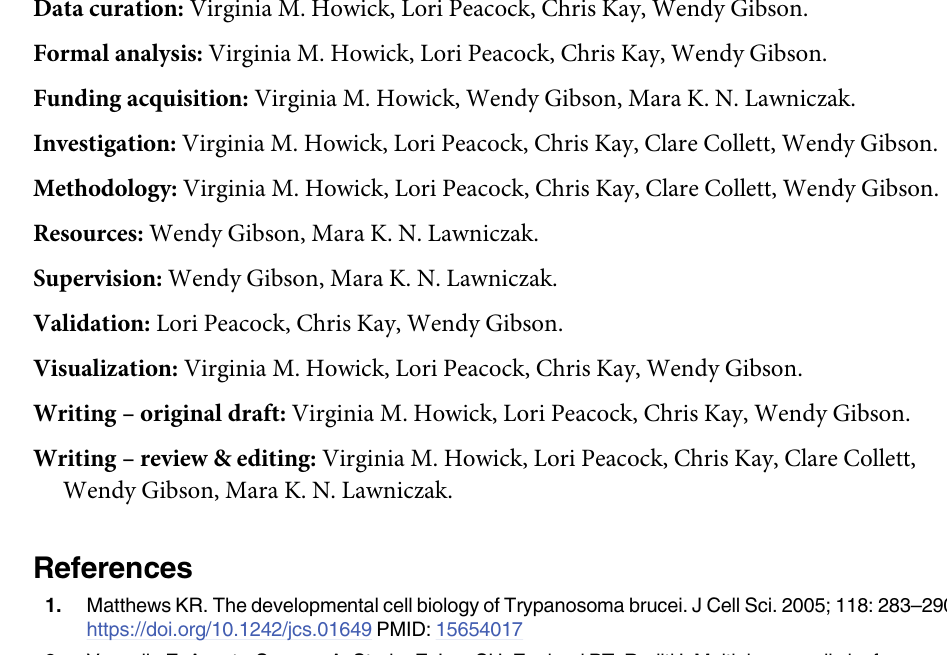
S5 Table. Genes differentially expressed between strains (corresponding to S5 Fig). S6 Table. Surface protein expression of trypanosomes from salivary glands from tsetse dis- sected 19–21 days post infected feed, using